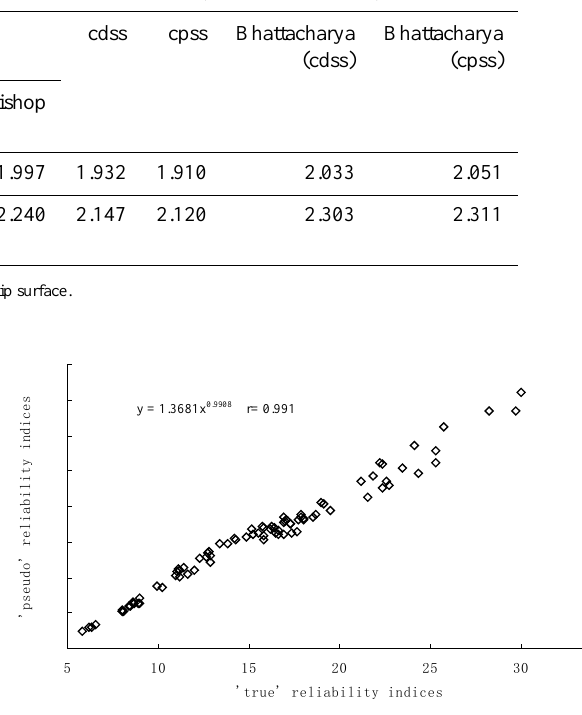
Figure 10. Relationship between pseudo reliability indices and true reliability indices of 86 non-circular trial slip surfaces (log-normal distribution + load factor